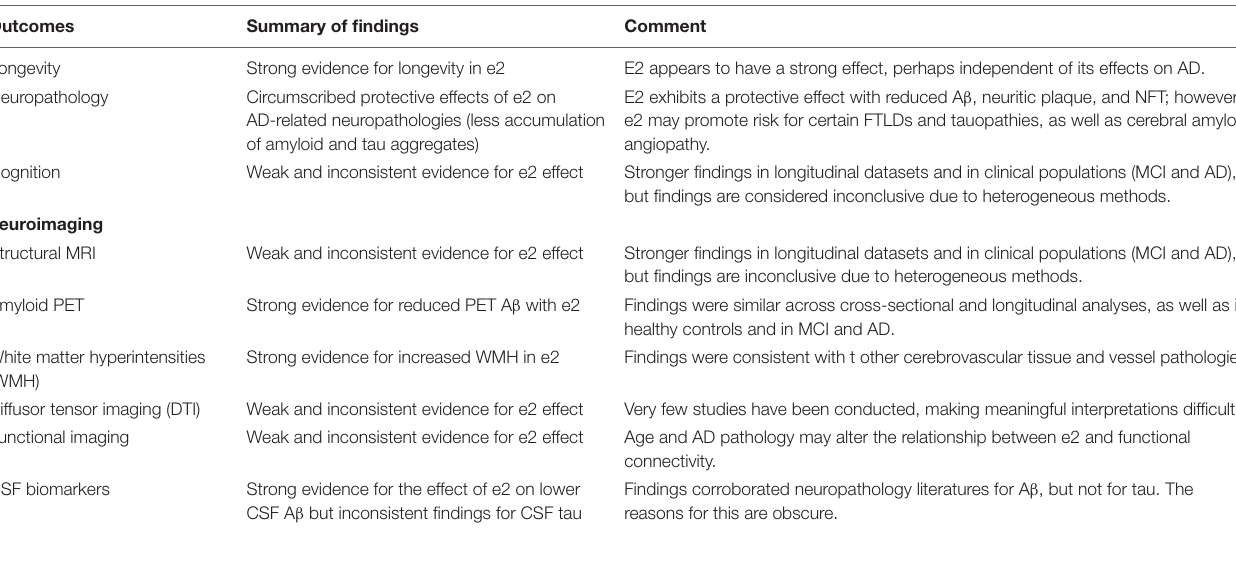
TABLE 1 | Summary of